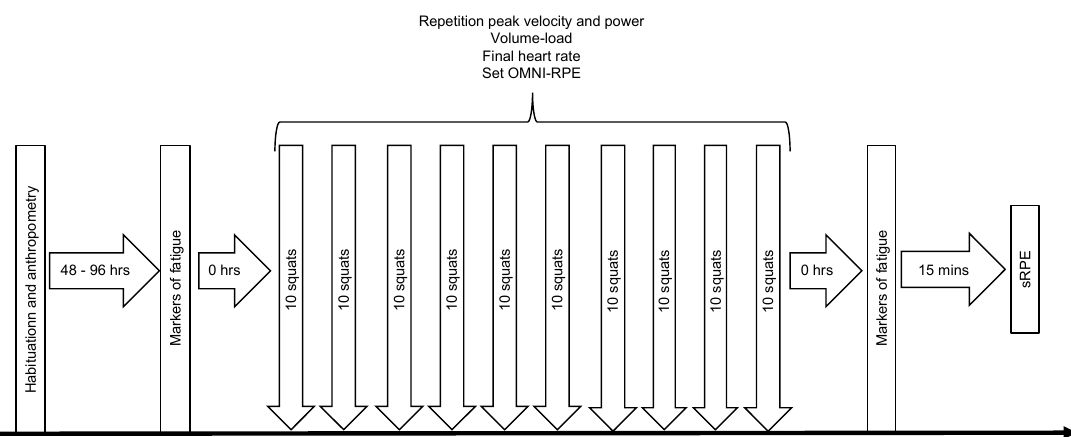
Figure 1. Schematic of study design.